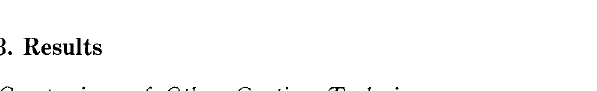
Fig. 4 SEYI micrographs at (a) low and (b) high magnifica tion of fumed silica particles coated on silicon